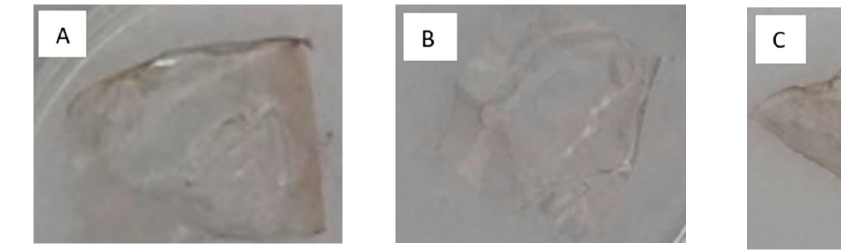
Table 3. Color parameters ( L—lightness, a—red (+) to green ( − ), b—yellow (+) to blue ( − b) and Δ E—total color difference ) of the